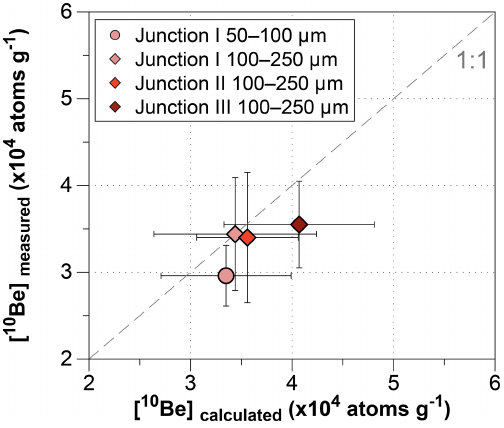
Figure 6. 10 Be concentrations of sediments at three river junctions calculated using Eq. (2) plotted against those measured in sediments downstream of the tributary junctions (Table 1). Junction I is the Var–Tinée junction, measured at VAR-16-3; Junction II is the Var– Vésubie junction, measured at VAR-16-4; and Junction III is the Var–Estéron junction, measured at VAR-16-5A/B. For Junction III, the measured concentration is the average of the concentrations in the 100–250µm size fractions at VAR-16-5A and